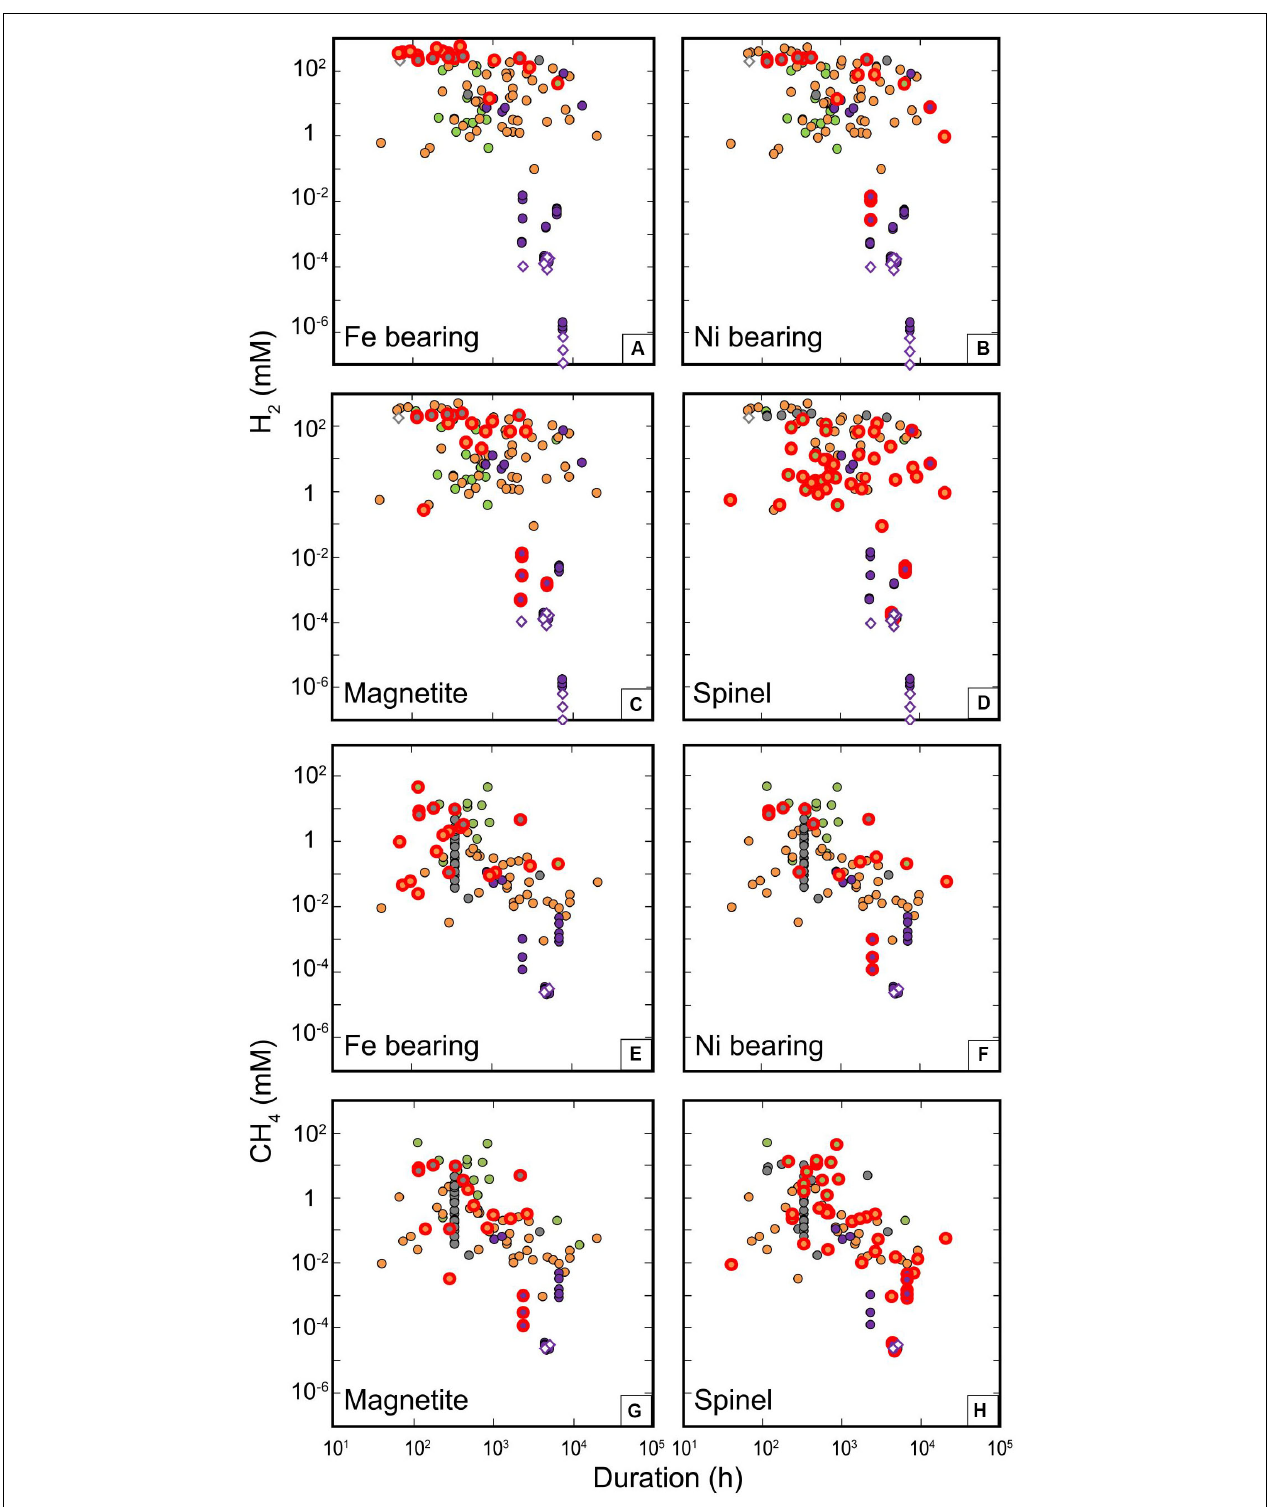
FIGURE 10 | Potential catalytic effects on the formation of H 2 and CH 4 . Concentrations of H 2 (A–D) and CH 4 (E–H) are plotted against run durations. Diamond symbols correspond to experiments without initial mineral phases, and red thick circles highlight the experiments with relevant catalyst reactants. (A) “Fe-bearing” ones include metallic iron, hematite, Ni-Fe alloys, FeS, FeO except magnetite; (B) “Ni-bearing” ones include NiS, Ni-Fe alloys; (C) “Magnetite” corresponds to experiments with magnetite; (D) “Spinel” corresponds to experiments with spinel or spinel-bearing peridotite. Color coding consistent with Figure 5 .